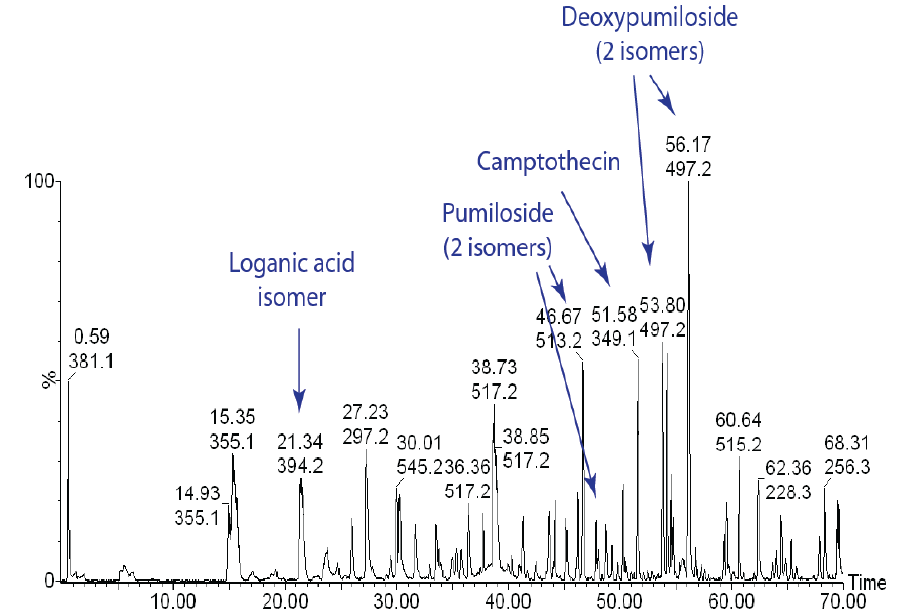
Figure 3. UHPLC/TOF-MS profile of metabolites extracted from C. acuminata